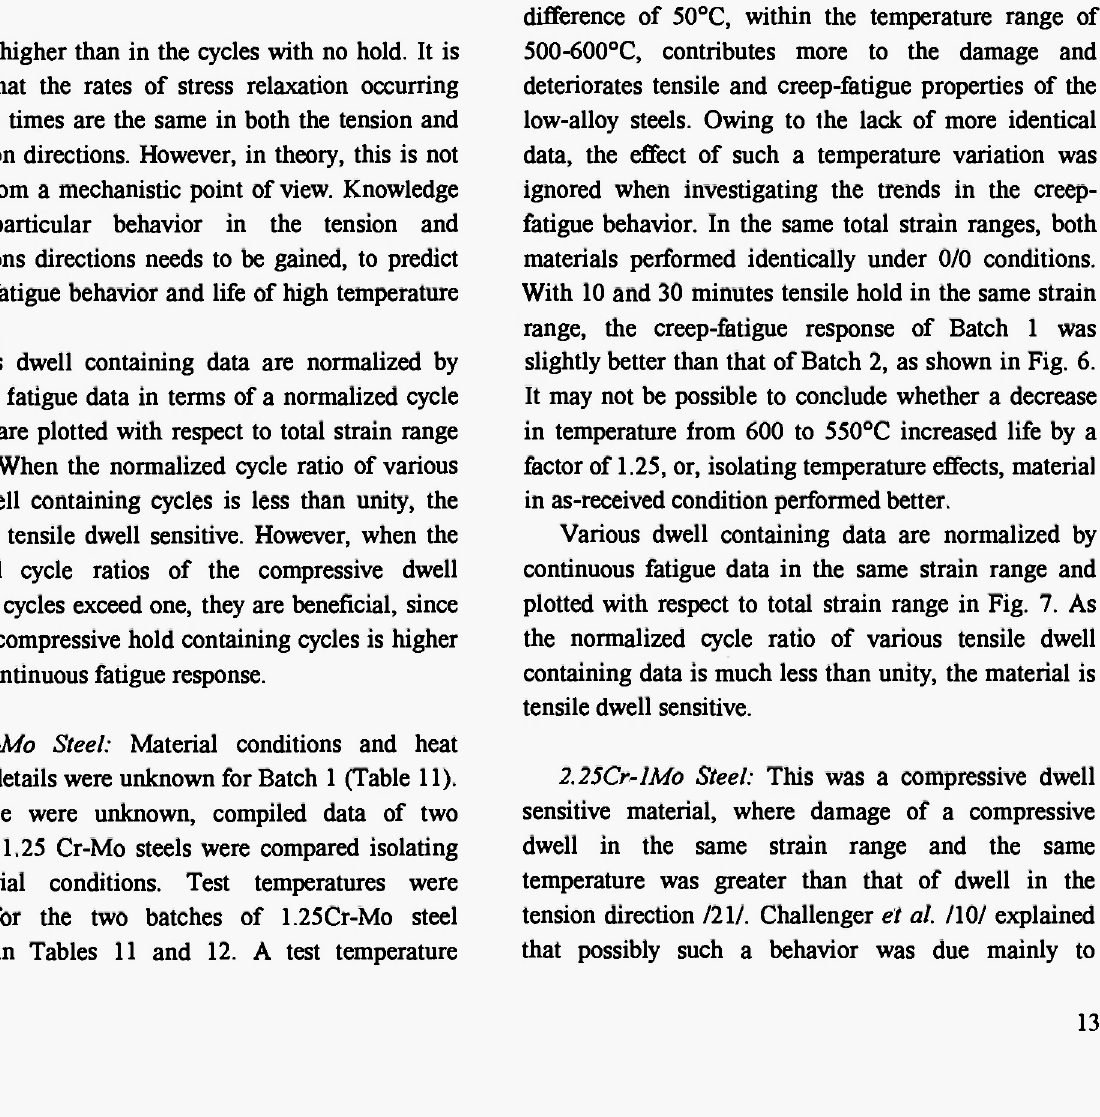
Fig. 4: Creep-fatigue behavior of lCr-Mo-V steel with different hold times.